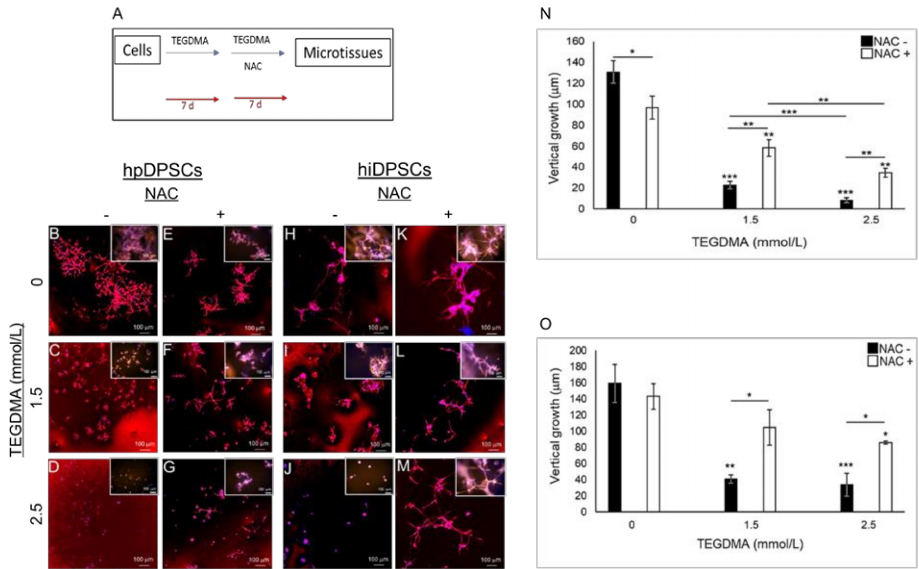
Figure 3. The spatial structure of developing microtissues pre-exposed to TEGDMA prior to treatment with NAC. ( A ) Schematic diagram of the experimental assay. ( B – M ) Confocal images of ( B – G ) hpDPSC and ( H – M ) hiDPSC microtissues ( B , E , H , K ) non-exposed versus exposed to ( C , F , I , L ) moderate and ( D , G , J , M ) high concentrations of TEGDMA before ( E – G , K , L , M ) treatment with NAC. ( N – O ) Bar graphs comparing the thickness of the ( N ) hpDPSCs and ( O ) hiDPSCs structures non-treated vs. treated with NAC. * p ≤ 0.05, ** p ≤ 0.01, *** p ≤ 0.001.